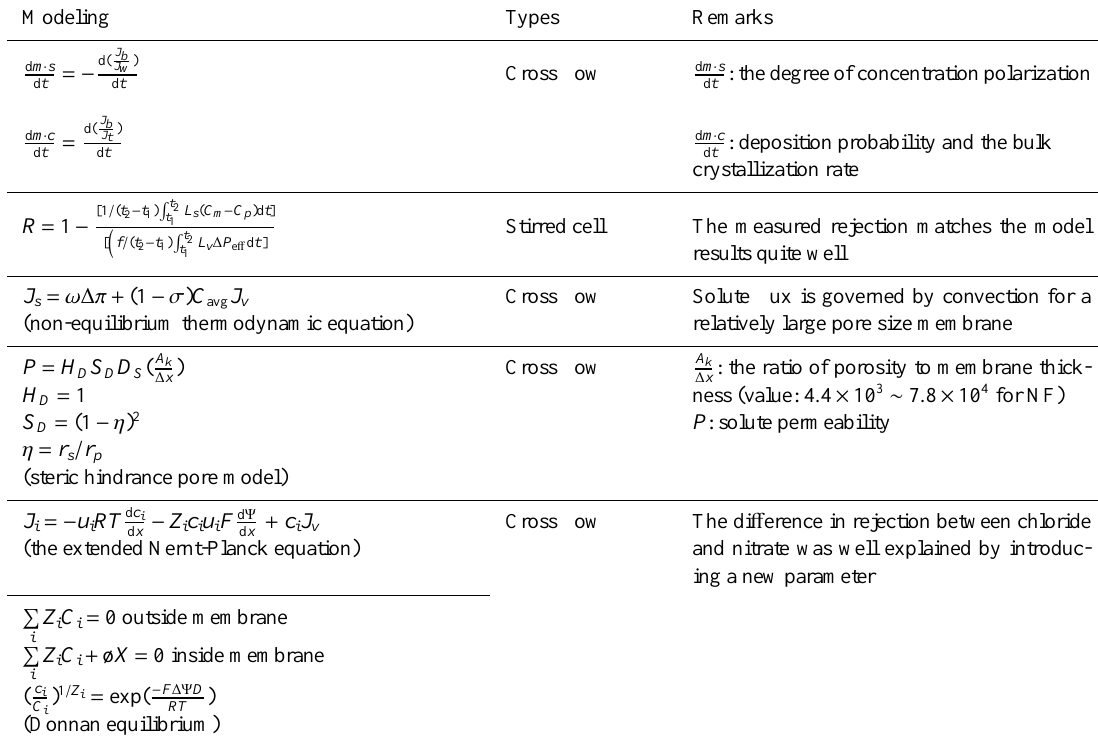
Table 3. Summary of the mathematical modeling work on Nanofiltration Modeling